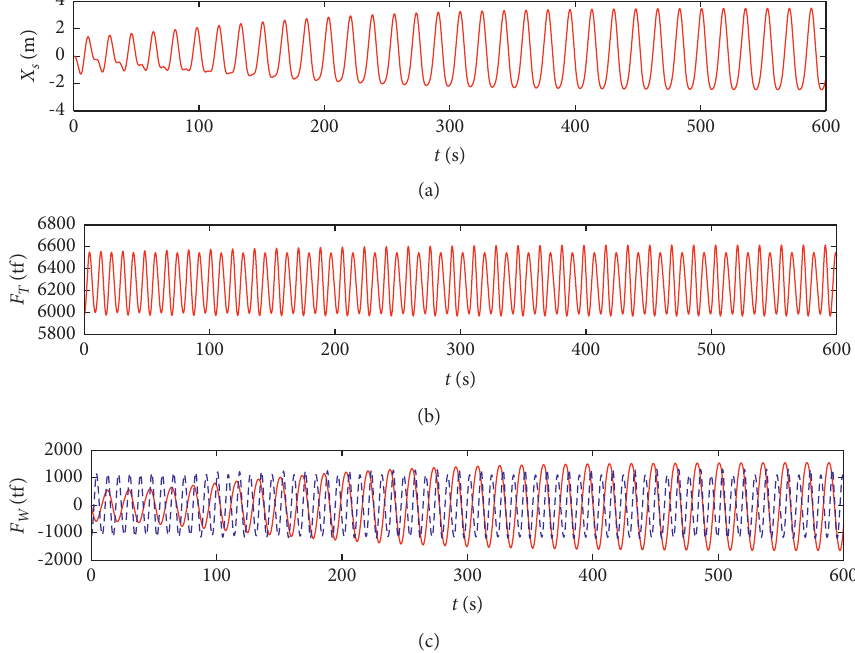
Figure 9: The time history of (a) tube displacement X s , (b) mooring cable tension F T , and (c) wave force F W (the solid line represents horizontal wave force and the dotted line represents vertical wave force) under wave period equal to 8.75s, wave steepness equal to 0.04, and BWR equal to 2.6.